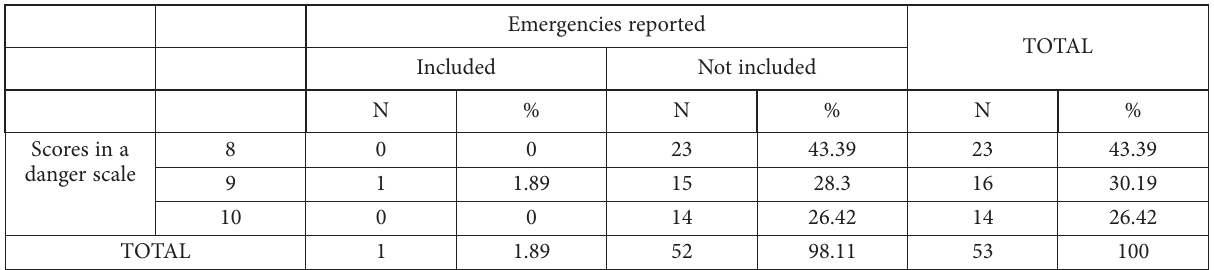
Table 4. Contingency analysis results for the emergency situations of the last quartile Emergencies reported Included Not included